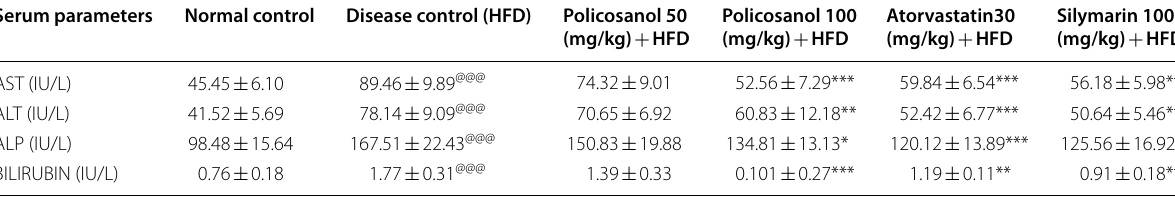
Data are represented as mean @@@ p < 0.001 compared with the normal control group * p < 0.05 compared with the HFD